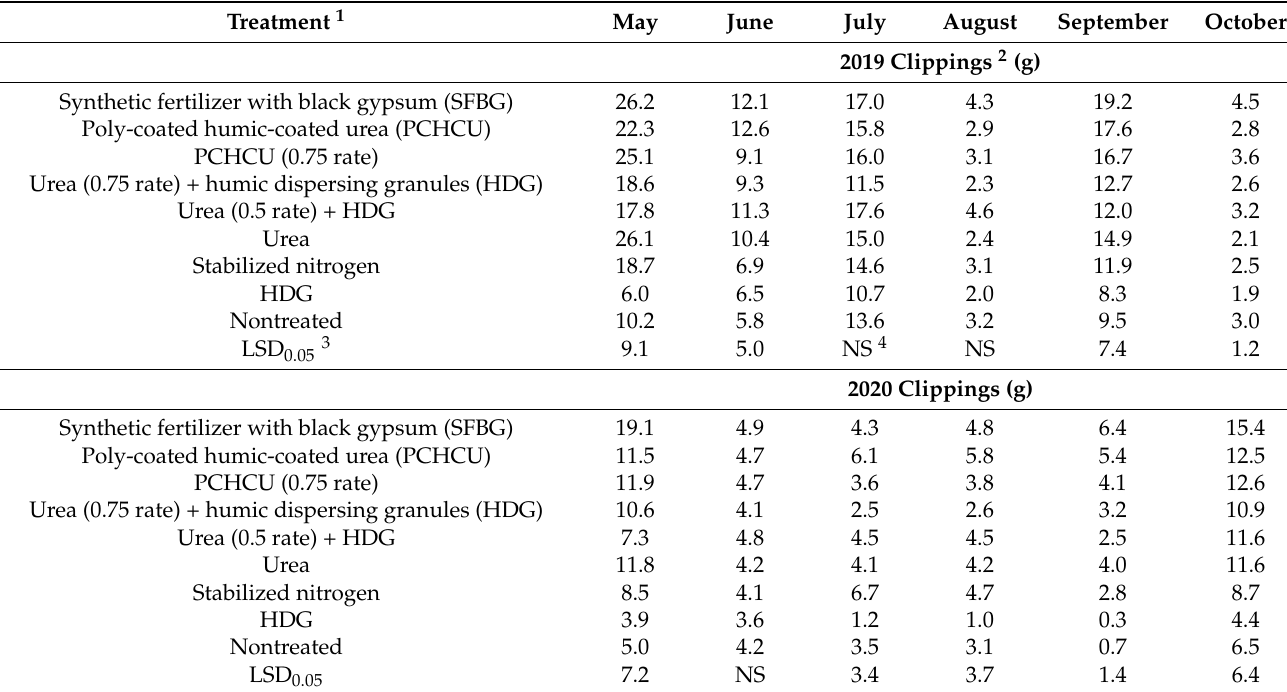
Table 5. Effects of various fertilizers on clipping dry weight of a native soil Kentucky bluegrass maintained at 7.6 cm in Ames, IA, USA in 2019 and 2020.